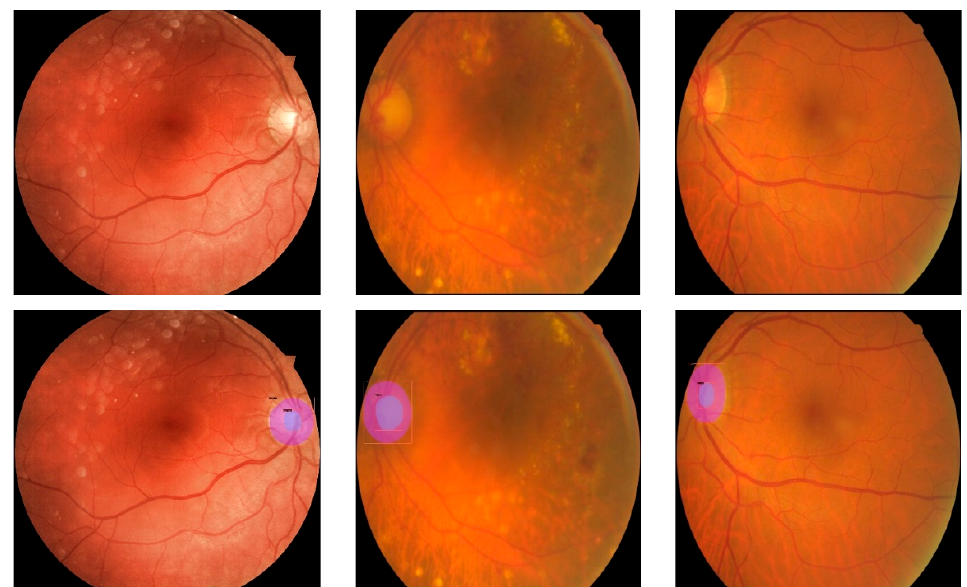
Figure 10. Output result from MS-RCNN on some images from test G1020 dataset. First row original images, second row segmented images.